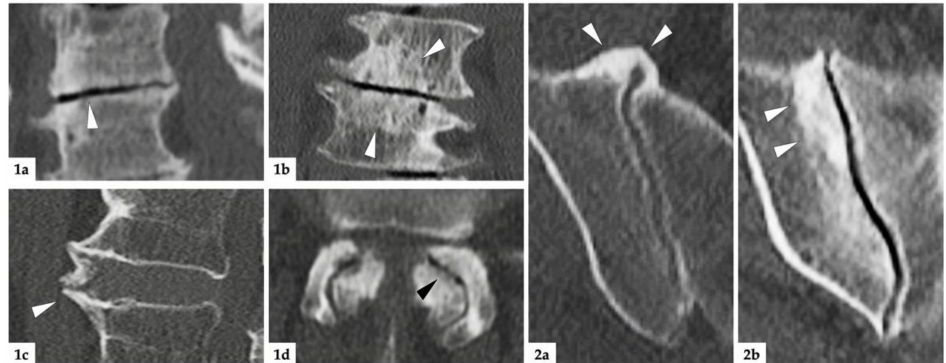
Figure 2. Imaging examples. ( 1 ): Degenerative lesions of the lumbar spine; ( 1a ) = sagittal recon- struction: white arrowhead marks discal vacuum phenomenon and narrowing of intervertebral space; ( 1b ) = coronal reconstruction: white arrowheads mark sclerosis of endplates; ( 1c ) = sagittal reconstruction: white arrowhead indicates spondylophyte; ( 1d ) = axial reconstruction: black arrow- head marks intraarticular vacuum phenomenon. Additionally, note the extensive sclerosis and joint space irregularities from OA of the facet joints. ( 2 ): degenerative lesions of the SIJ; ( 2a ) = axial recon- struction: ventrally located, bridging osteophytes of the right SIJ marked with white arrowheads; ( 2b ) = oblique-coronal reconstruction: extensive sclerosis around the joint (white